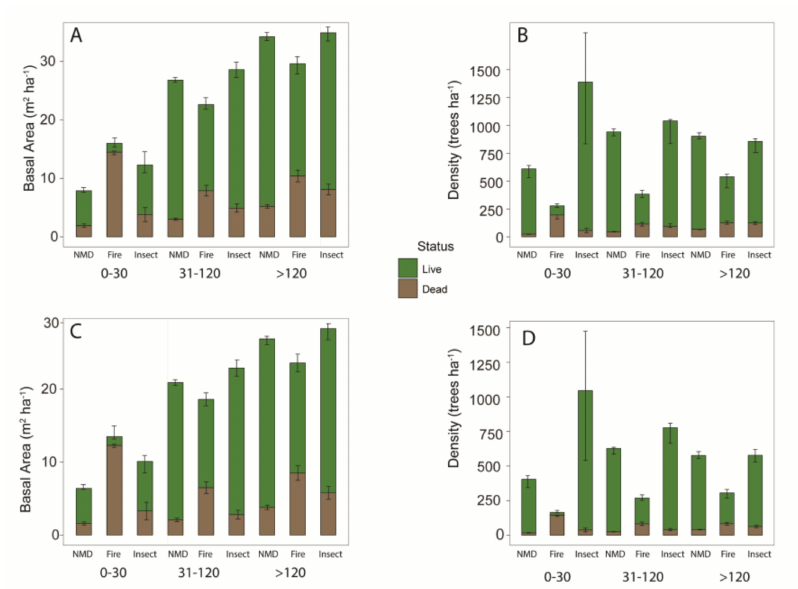
Figure 3. ( A ) Mean total basal area (m 2 ha − 1 ) for live and dead standing trees; ( B ) mean density for the total number of live and dead trees (trees ha − 1 ); ( C ) mean basal area for live and dead Douglas-fir (m 2 ha − 1 ); ( D ) mean density of live and dead Douglas-fir trees (trees ha − 1 ) grouped by disturbance type and stand development stage. Error bars are one standard error above and below the